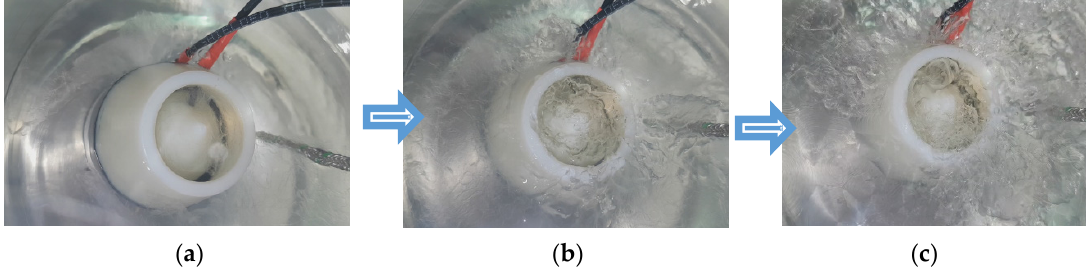
Figure 3. Picture of the reference capacitor inserted in slush nitrogen during different stages of the freezing cycle: ( a ) after 20 s; ( b ) after 50 s; ( c ) after 100 s.